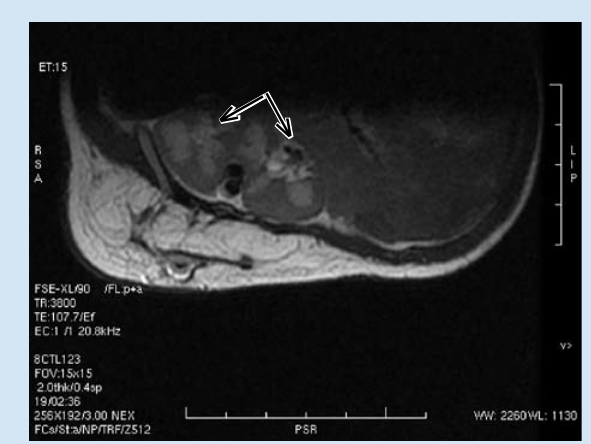
Fig. 2b. Axial T2 MRI demonstrates horseshoe kidney